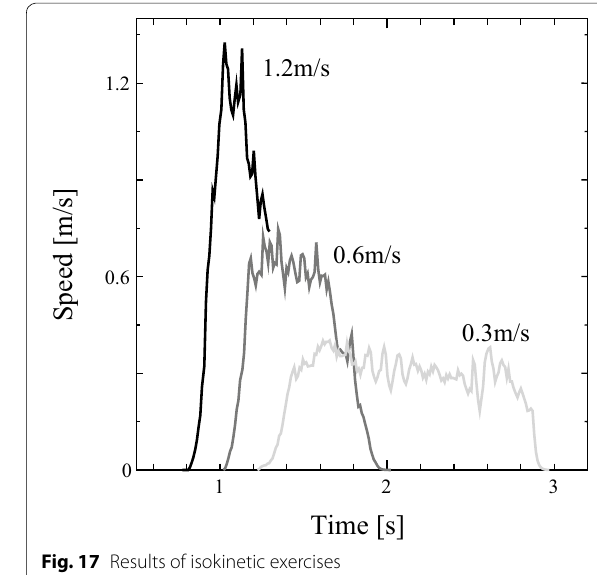
Fig. 16 Force response in terminal resistance mode exercise